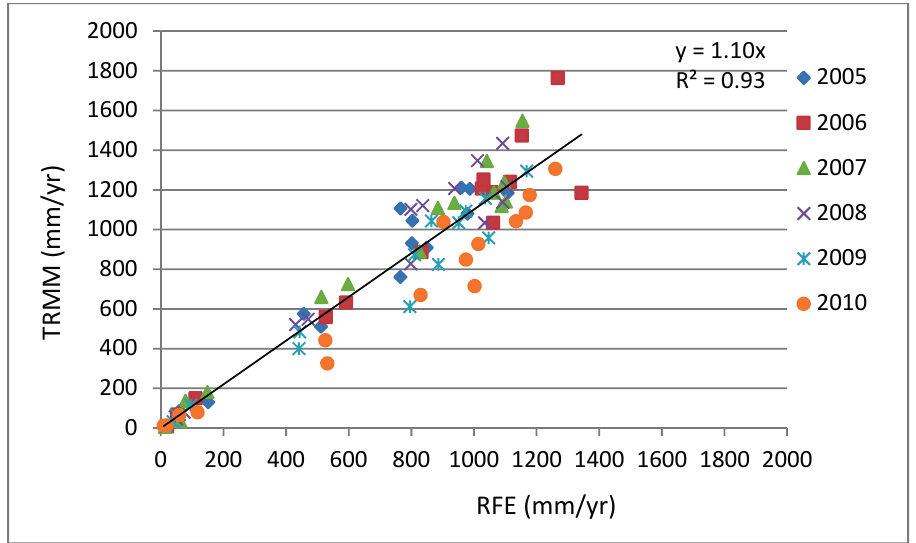
Figure 3. Annual rainfall data from TRMM 3B43 and FEWS-NET RFE presented by sub-basin (n = 15) for the period 2005–2010 (n = 6).